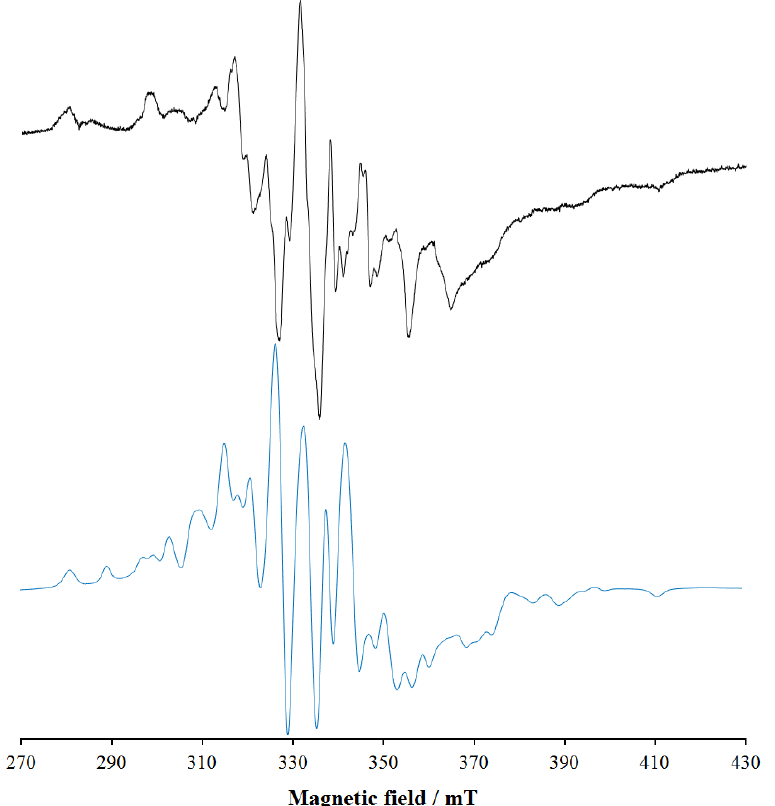
Figure 11. Experimental (top) and simulated (bottom) EPR spectrum of [(V IV O) 2 (L4) 2 (H 2 O) 2 ] (V IV O 2+ - L4 1:1, V IV O 2+ concentration 1 mM, pH 5.1). The spectrum was simulated with EasySpin software, considering two V IV O ions with S = 1/2 coupled with J = 0.11 cm − 1 . For each V IV center g x,y,z = {1.979, 1.979, 1.943} and A x,y,z = {52.5, 52.5, 170.1} × 10 − 4 cm − 1 were used. Gaussian and Lorentzian broadening were set to 1.4 and 1.4 mT.